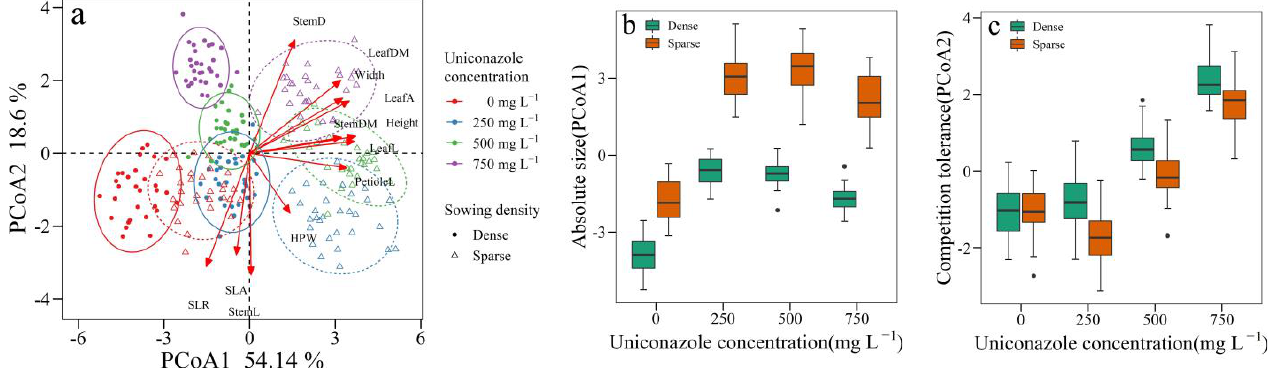
Figure 5. The result of principal coordinate analysis in two sowing densities using treatment with uniconazole. ( a ) the result of principal coordinate analysis. Sparse and dense represent sowing densities of 400 and 800 seeds per tray, respectively. Arrows represent principal component loadings for each attribute. “Height” is seedling height, “Width” is seedling width, “StemL” is stem length, “StemD” is stem diameter, “LeafDM” is leaf dry matter, “StemDM” is stem dry matter, “LeafA” is leaf area, “LeafL” is leaf length, “PetioleL” is petiole length, “SLR” is stem/leaf ratio, “SLA” is special leaf area, “HPW” is height per width of seedling. ( b ) Boxplot showing seedling trait variation in absolute size in response to uniconazole treatment in two sowing densities. ( c ) Boxplot showing seedling trait variation in pressure tolerance in response to uniconazole treatment in two sowing densities.